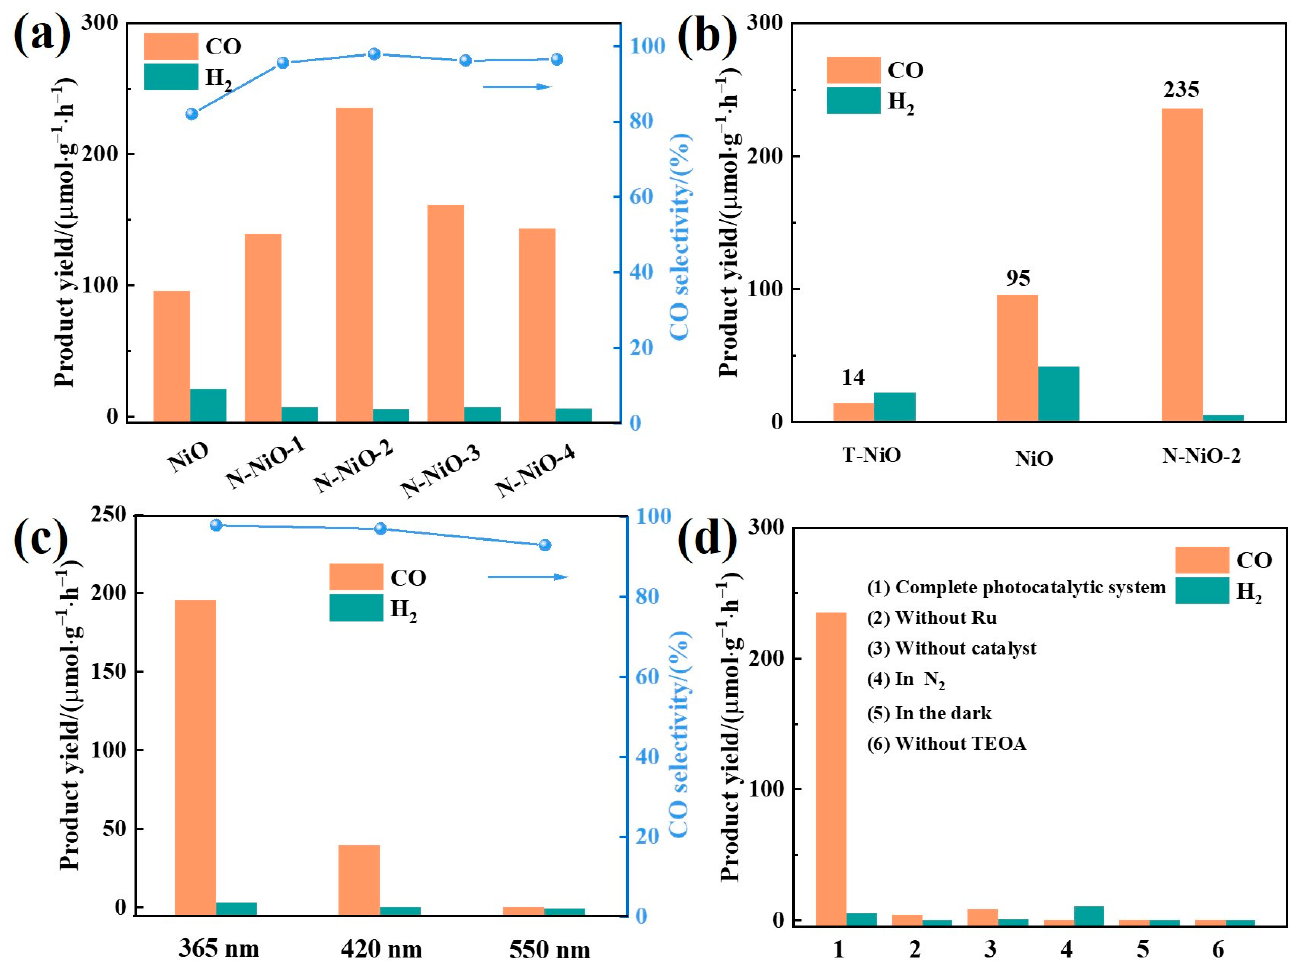
Figure 5. ( a ) Product yields and CO selectivity of NiO and N-NiO-x at 365 nm; ( b ) product yields of T-NiO, NiO, and N-NiO-2 at 365 nm; ( c ) product yield and CO selectivity of N-NiO-2 at different wavelengths; ( d ) product yields of N-NiO-2 under different reaction conditions.